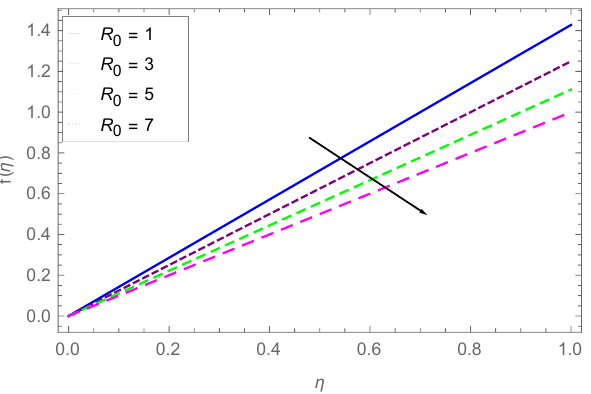
Figure 12. Graph showing f ( η ) dependence on R 0 .